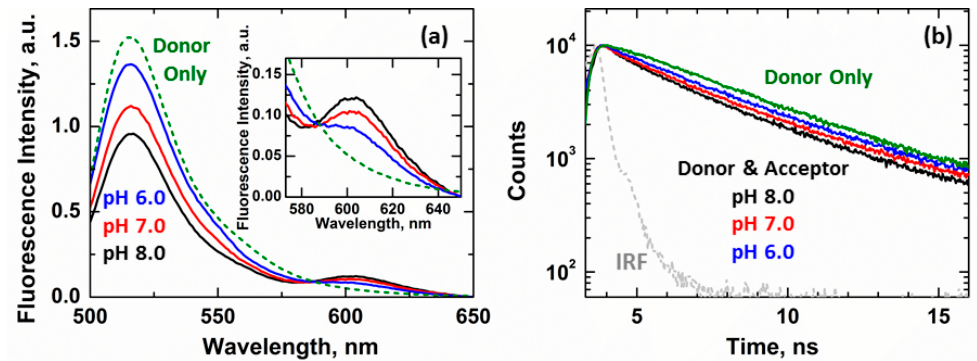
Figure 5. Ensemble FRET measurements of the release of the N-terminal BH4 domain ( α 1 helix). The release of the BH4 helix was measured by loss of FRET between an N-terminally conjugated mCherry fluorescent protein and the fluorophore Alexa-Fluor-488 (A488) introduced at position D189C in Bcl-xL (Figure 2). ( a ) Steady-state measurements in the presence of 1TOCL:2POPC LUV showed a progressive increase in donor A488 intensity at 518 nm as a function of pH. This was accompanied by a decrease in the acceptor mCherry intensity at 605 nm (insert). These spectral changes were indicative of a loss of FRET between both fluorophores and indicated the increase in distance between donor and acceptor, attributed to the release of the N-terminal BH4 helix. Insert shows a re-scale of the acceptor band. ( b ) Lifetime measurements showed an increase in the fluorescence lifetime of the donor-acceptor samples at increasingly acidic conditions. This was indicative of lower FRET due to a decrease in the interactions between the donor-acceptor pair, consistent with the increase in distance between both fluorophores due to the release of the BH4 helix. The following amplitude average lifetimes were calculated for the donor-acceptor pair in the presence of 1TOCL:2POPC LUV: pH 8 τ α = 2.15 ns (black), pH 7 τ α = 2.76 ns (red), pH 6 τ α = 3.03 ns (blue). The lifetime τ α = 3.42 ns was determined for a donor-only sample in the presence of LUV (green). The internal response function (IRF) of the instrument is indicated in